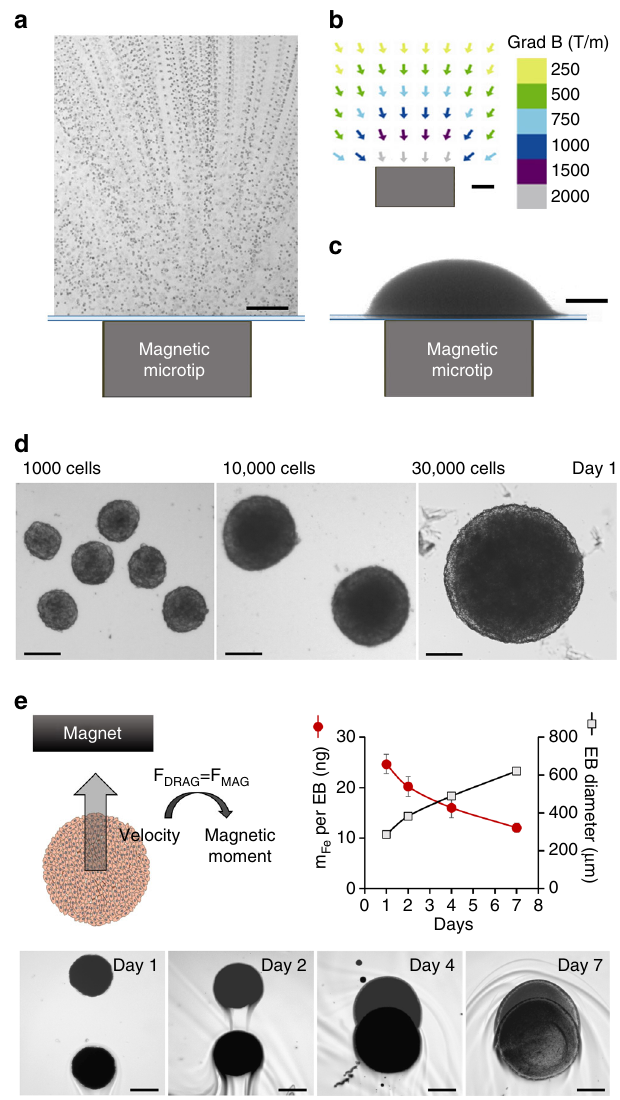
Fig. 3 Magnetic formation of embryoid bodies. a ESC attraction by a magnetic microtip (750 µ m in diameter). To visualize cell movement, the microtip was introduced into a chamber containing suspended cells under a microscope, and cell movements were video-monitored with a ×10 objective. Here 100 movie images were superimposed (0.1 s time intervals) in order to directly observe the trajectories of the cells migrating towards the magnetic microtip. At 1 mm from the microtip, the cells migrate at an average velocity of 300 µ m/s, which corresponds to an iron mass of 3 pg cell in a magnetic fi eld gradient of 300 mT/mm. b The fi eld gradient was mapped around the microtip by studying the migration of monodisperse magnetic beads with a calibrated diameter of 4.6 µ m (Dynal). At 1 mm from the microtip, it was 300 mT/mm. Scale bar : 200 µ m. c Final image of the aggregate obtained 1 min after seeding 30 000 ESCs over the magnetic microtip. Scale bar : 200 µ m. d Microscopic images of embryoid bodies (EBs) on day 1, obtained by seeding 1000, 10,000 and 30,000 cells per microtip. Scale bar : 200 µ m. e Monitoring of EBs magnetism over 7 days after nanoparticles cellular incorporation, and EB formation (day 0). It consists of tracking the EB magnetic migration towards a magnet, and measuring the corresponding velocity, which translates into the EB magnetic moment (proportional to the mass of iron per EB) by balancing the viscous drag and the magnetic force. Typical migrations are shown for the different times (days 1, 2, 4 and 7), corresponding to the superimposition of two images at 3 s interval. Scale bar : 200 µ m. The mass of iron ( circles ) and the EBs diameters ( squares ), averaged over eight different EBs, were then plotted as a function of time. Error bars represent the